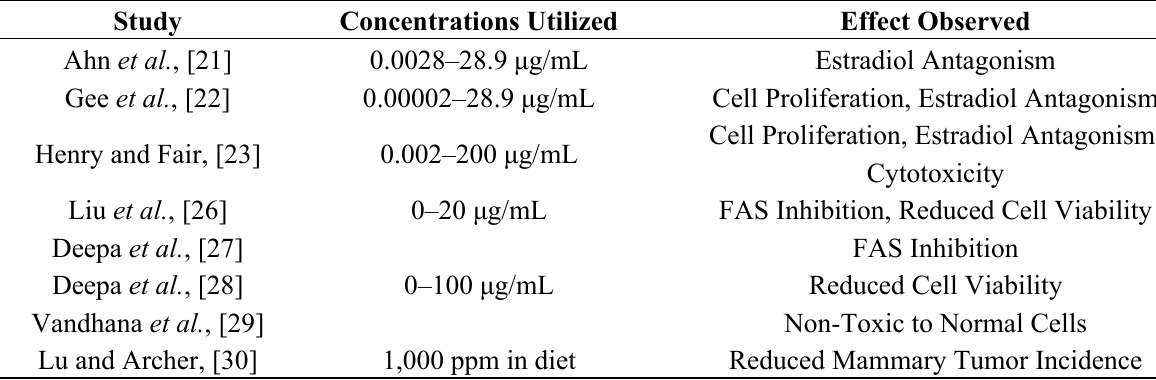
Table 2. Studies of Triclosan and